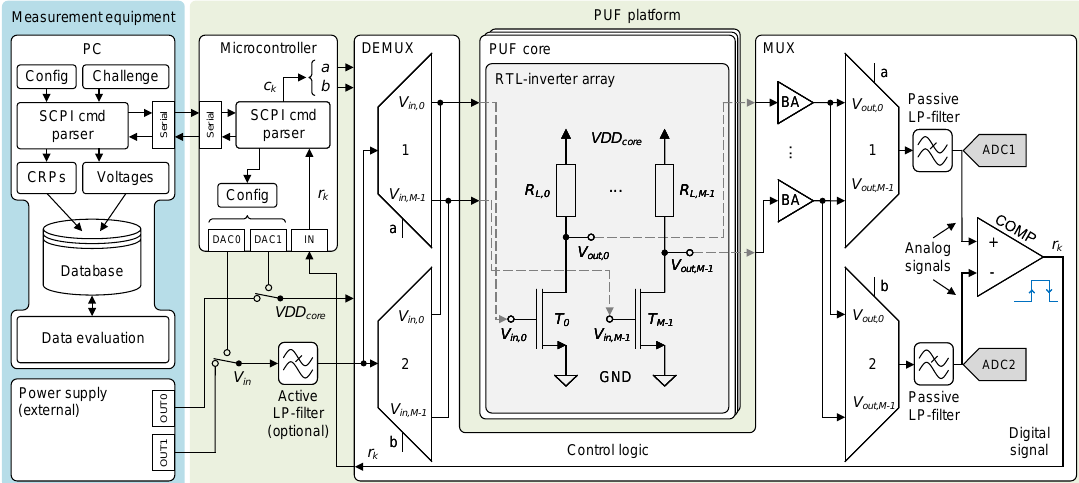
Figure 1. PUF platform block diagram (DAC: Digital-to-analog converter, ADC: